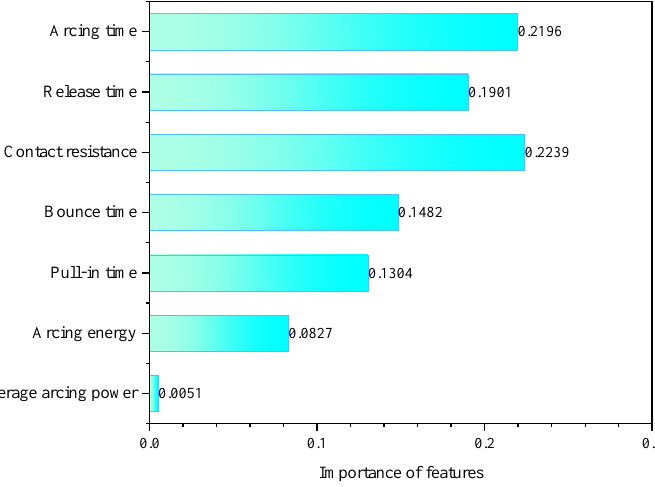
Figure 16. Comparison of NCA feature importance analysis.